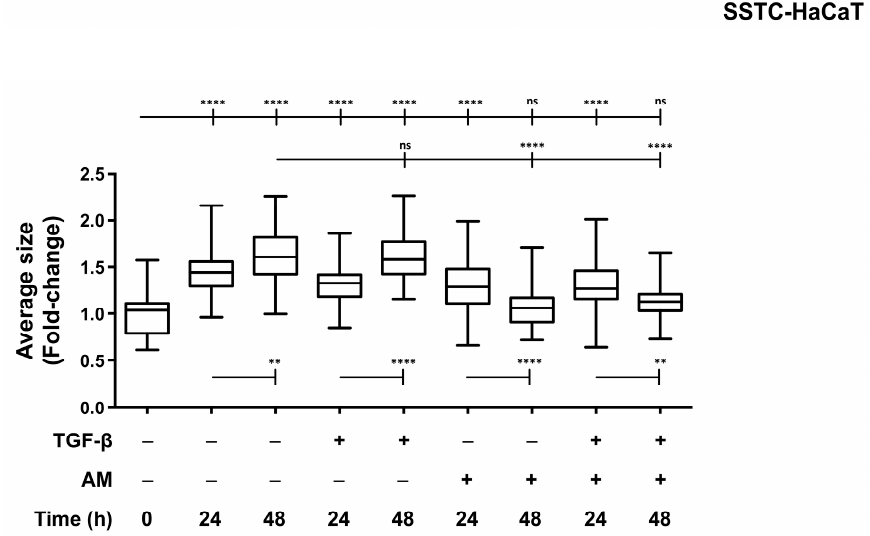
Figure 4. Amniotic membrane treatment restricts swelling responses in HaCaT cells persistently exposed to TGF- β . The morphology and size of monolayer cells at the wound edge were studied. Results are shown as fold-change of SSTC-HaCaT cells regarding the same parameters of SS-HaCaT cells and in relation to adjuvant treatments. Replicates from three independent experiments were analyzed. Shown data represent the mean ± SEM. Asterisks denote statistically significant differences (** p < 0.005; **** p < 0.00005); ns, non-significant.